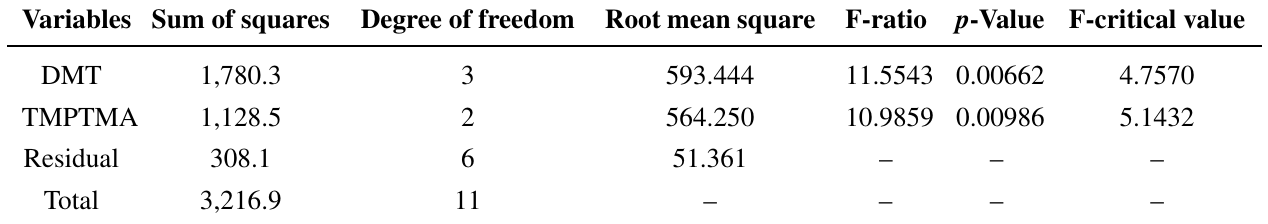
Table 3. Two-way ANOVA for working life of acrylic polymer concrete cured at 0 ˝ C. Variables Sum of squares Degree of freedom